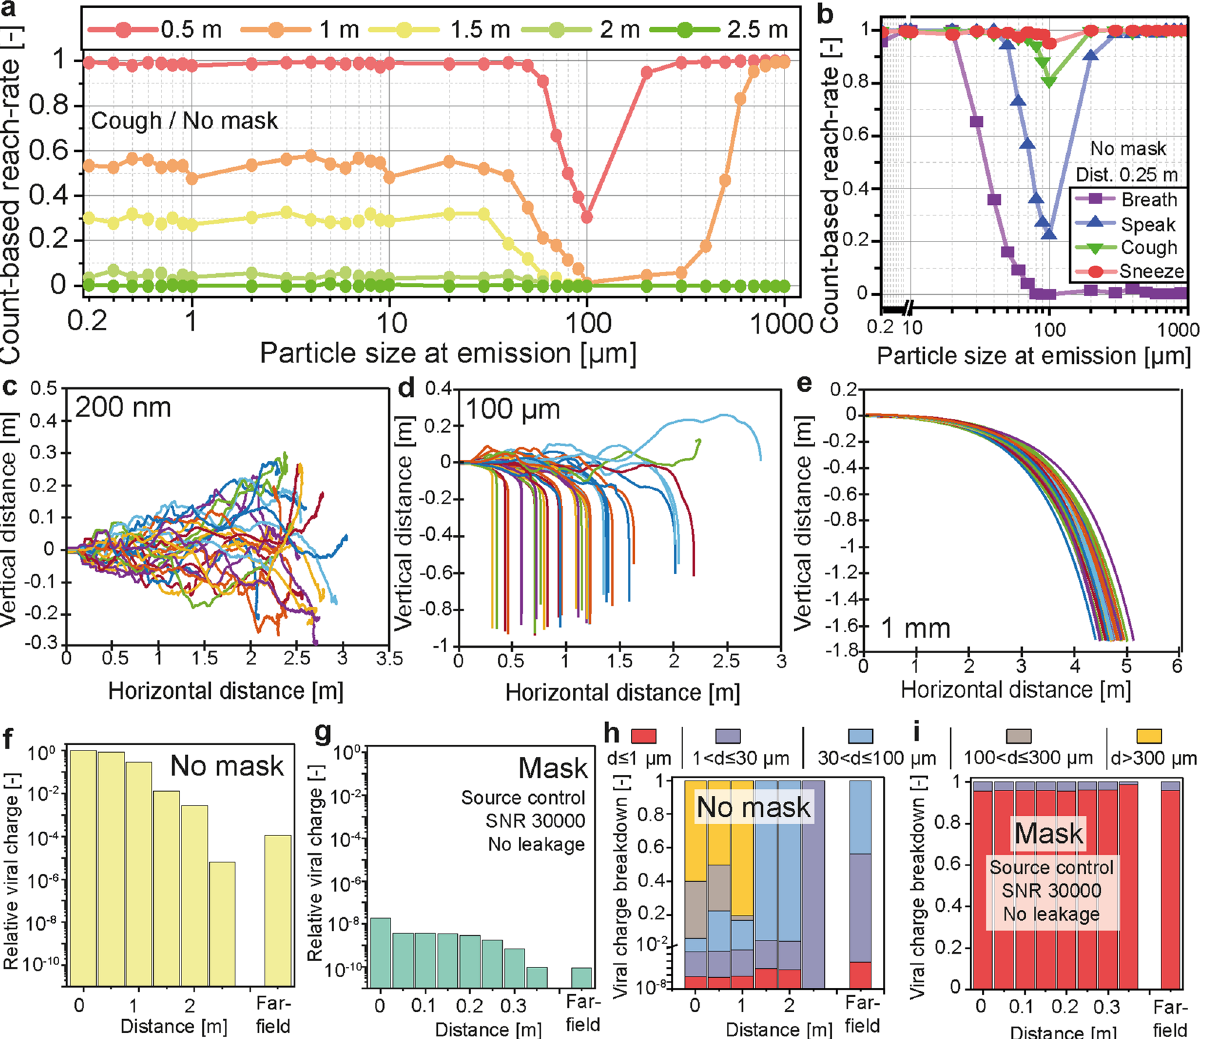
Figure 4. Horizontal spread of the emitted particles with and without a mask. The number-based reach-rate was calculated from the count of particles of each size reaching the face of the receiver facing the emitter and located at different distances. The data presented in ( a ) show the reach-rate considering a single cough without a facemask. The receiver’s face was represented by a 15 cm diameter disk. The reach-rates of all four expiratory activities calculated at 0.25 m without a mask are given in ( b ). Trajectories used in the calculation of the reach- rate are given in ( c ) for 200 nm particles, ( d ) for 100 μm particles, and ( e ) for 1 mm particles. The number-based reach-rate was used to calculate the near-field exposure level at different distances without a mask ( f ) and with a SNR 30000 mask used as source control ( g ). The exposure level without a mask at 0 m is taken as the reference. The particles were divided into five size classes based on the data presented in ( a ) and considering the viral charge per droplet. The distributions of viral charge into the size classes corresponding to the data from ( f ) and ( g ) are presented in ( h ) and ( i